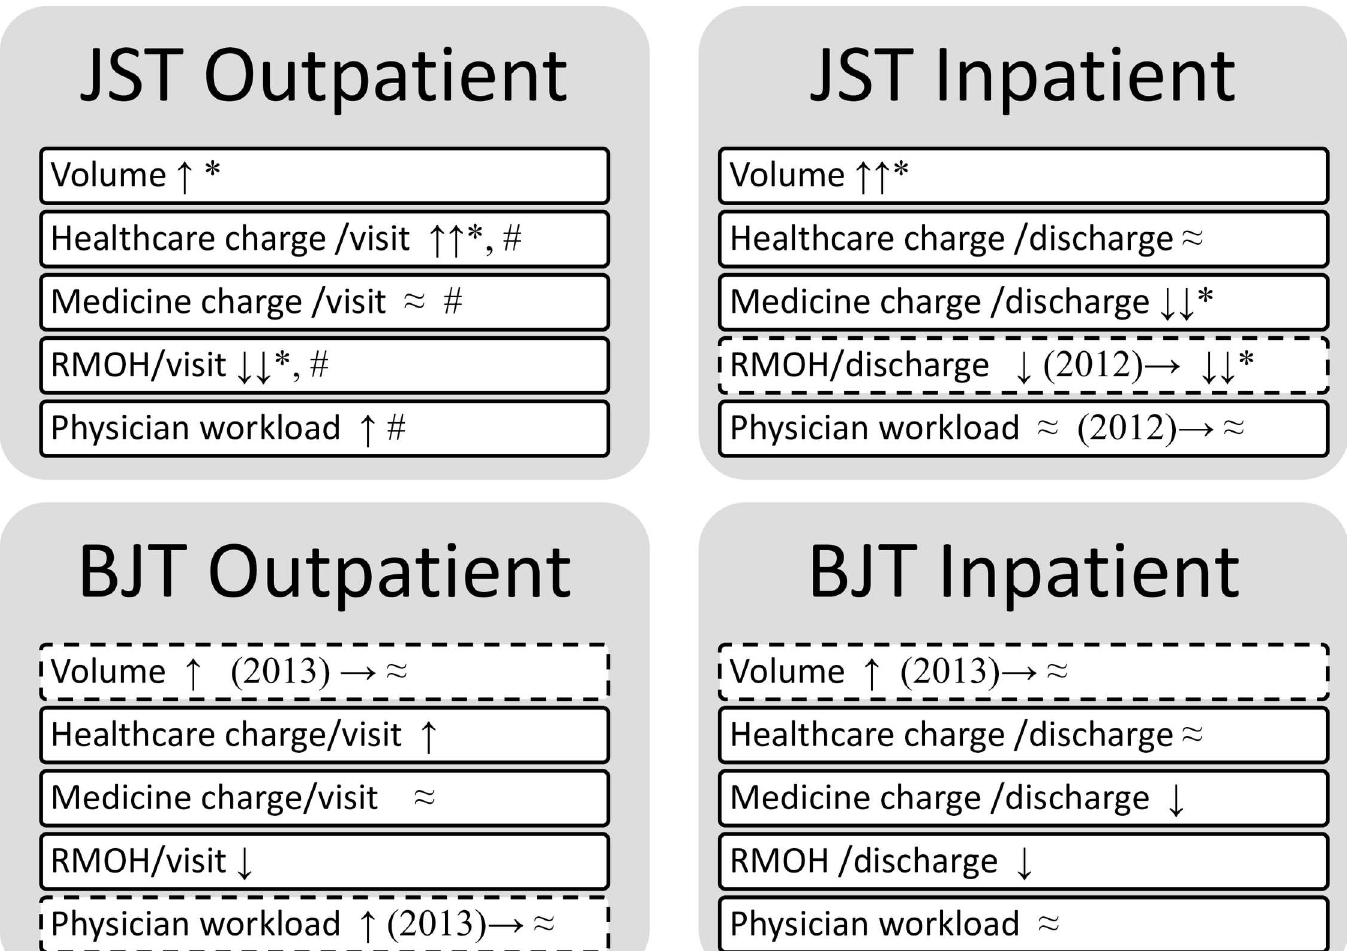
Fig 3. Summary of the differences in the trendsof outpatient and inpatientservices in Jishuitanhospital and the tertiaryhospitals in Beijing, China. The years indicatethe timesegmentswith significantchanges ( P < 0.05)revealed using the join-pointregressionanalysis. The dash-lined box indicates significant differences in the trends;JST: JishuitanHospitalat Xinjiekou campus, Beijing,China;BJT: The tertiaryhospitals in Beijing,China; (cid:25) : No significanttrendsidentified( P > 0.05); ! a join-pointidentified(join-point year in parenthesis); " : significantly increased annual percentagechanges ( P < 0.05); # : significantlydecreasedannual percentage changes ( P < 0.05); * significant difference in trendsbetween Jishuitanhospital and the tertiary hospitalsin Beijing;# significantdifference in trendsbetween outpatientand inpatientservicesof